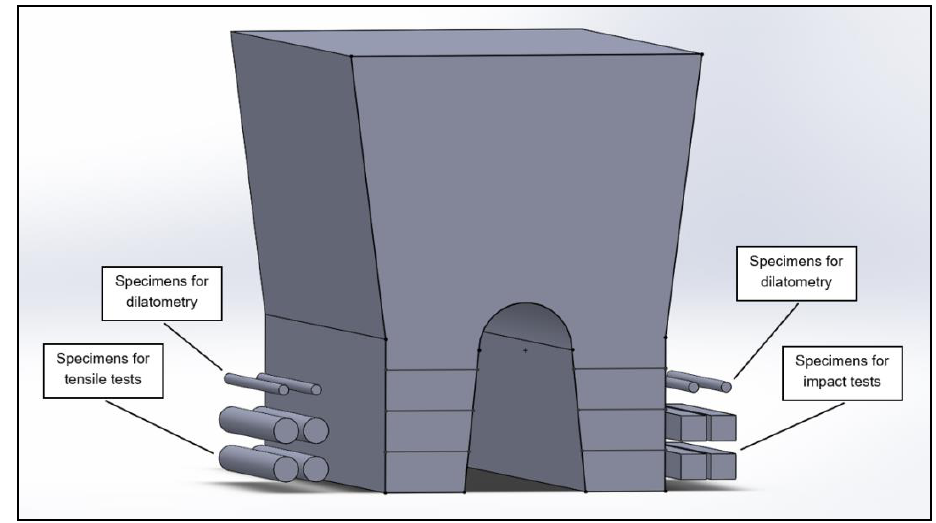
Figure 1. Keel-block scheme showing the different specimens used in this study and the location from where they were extracted and machined.